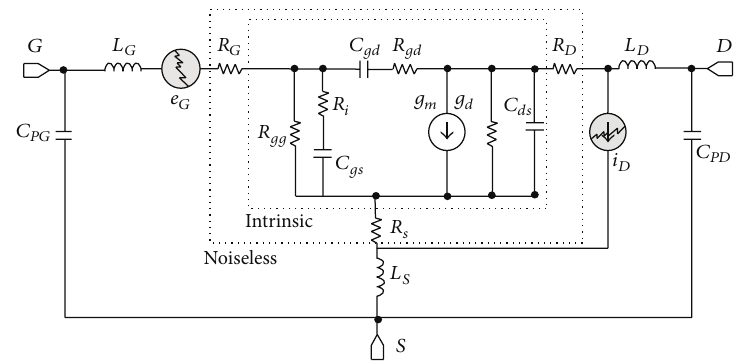
Figure 8: Small-signal equivalent circuit with noise sources for AlSb/InAs HEMT at 𝑉 𝑑𝑠 = 80 mV.